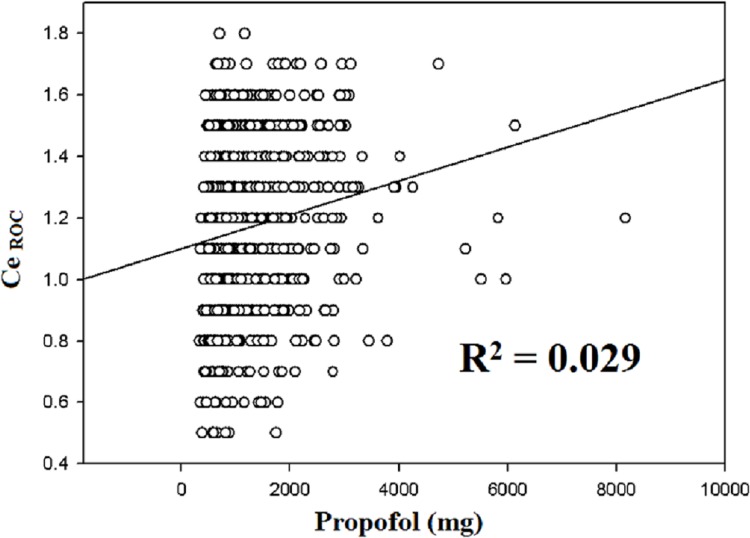
Linear regression between CeROC and consumption of propofol in 794 patients.Statistically significant correlation (R2 = 0.029; p < 0.01) and positive slope.